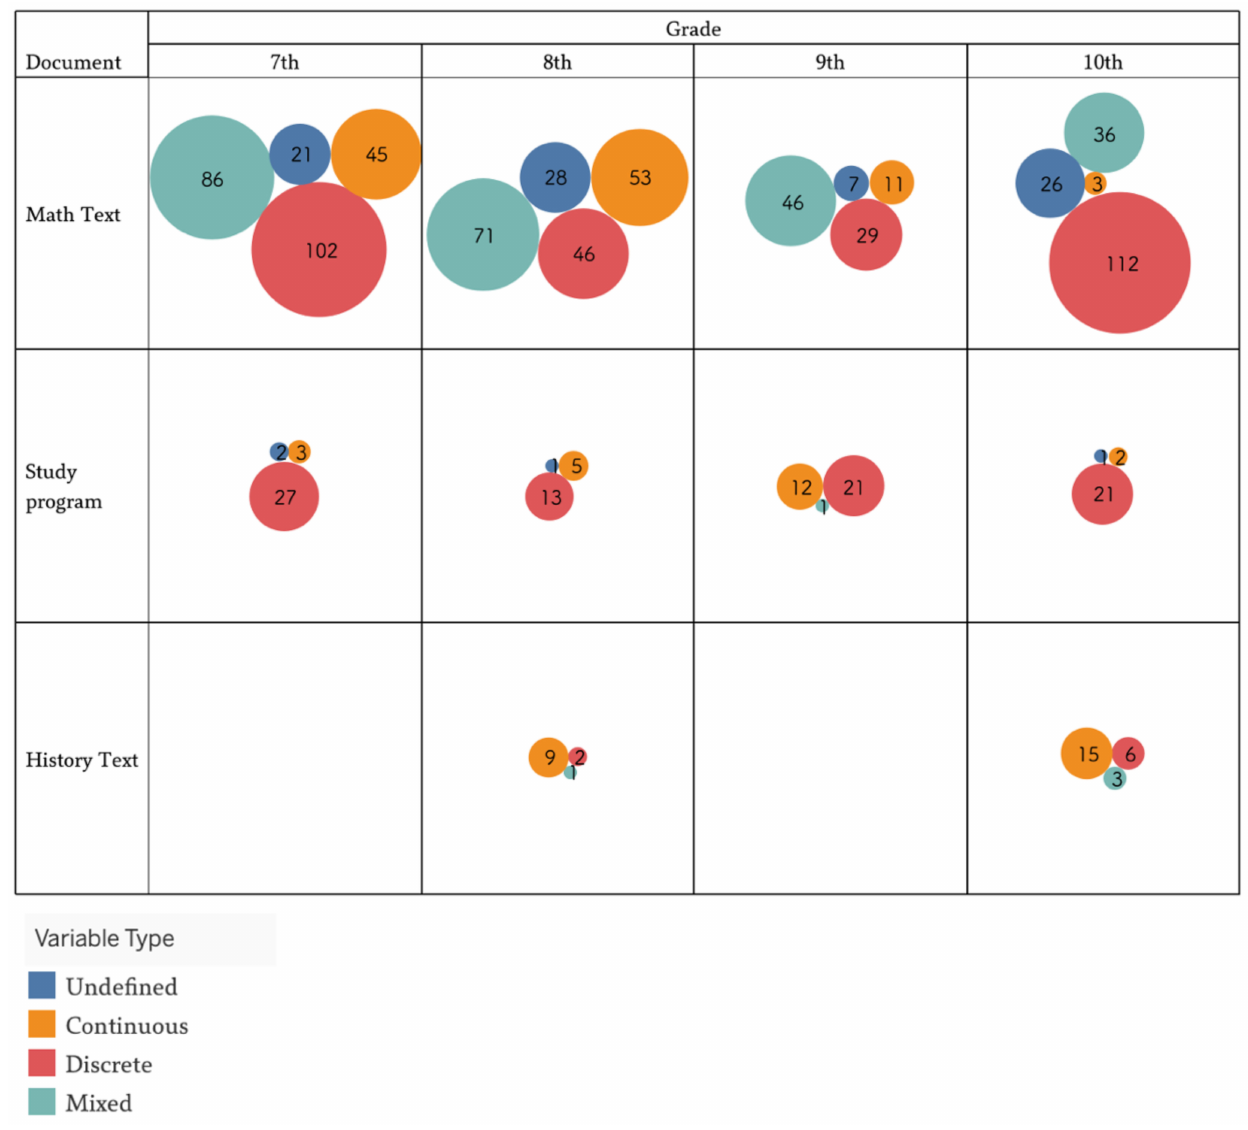
Figure 18. Presence of types of variable types (Source: Prepared by the